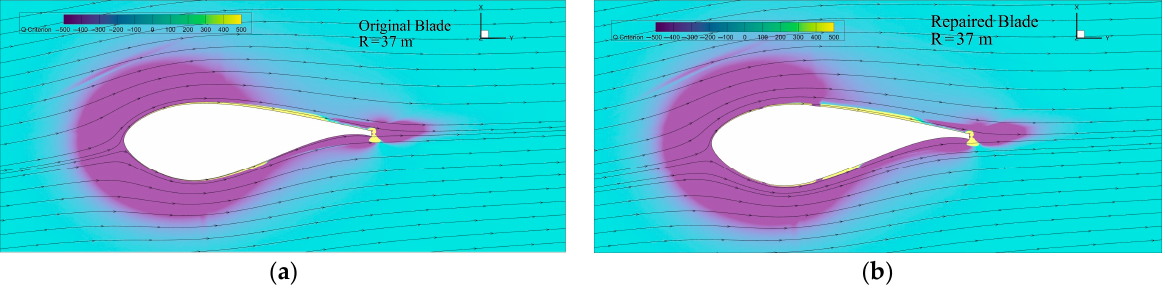
Figure 25. Flow field of the blade cross-section for R = 37 m: ( a ) the original blade; ( b ) the repaired blade.